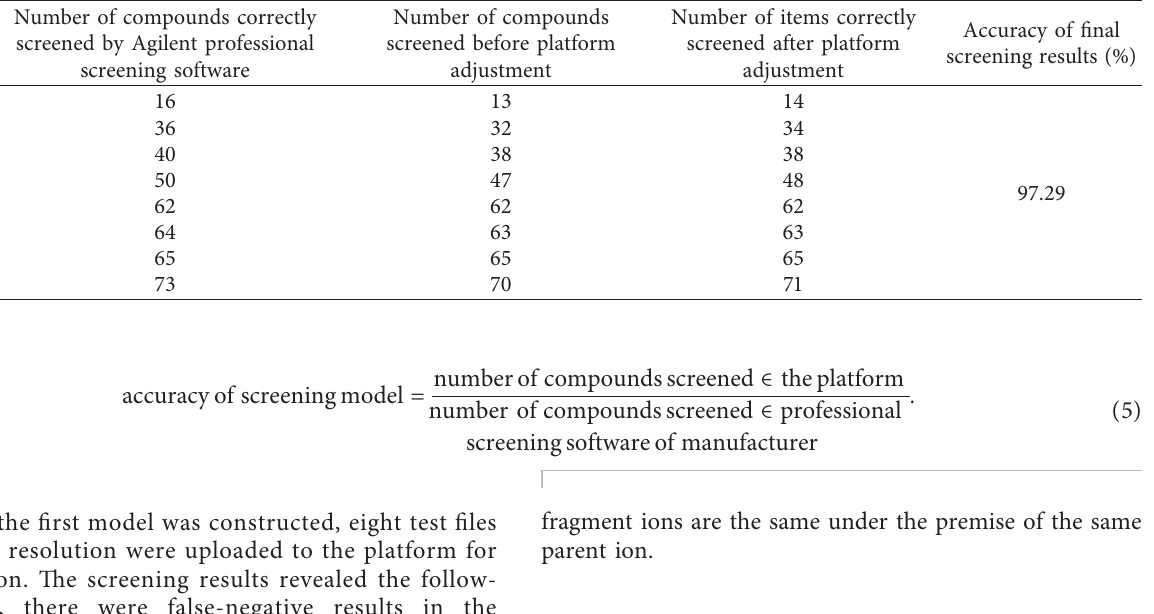
Table 2: High-resolution screening